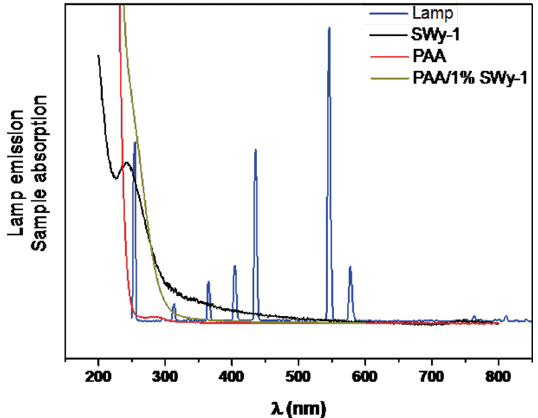
Figure 1. Emission spectra of irradiating lamp and absorption spectra of SWy-1, PAA and nanocomposite films Photodegradation was monitored by Fourier transform infrared spectroscopy, FTIR spectra were recorded